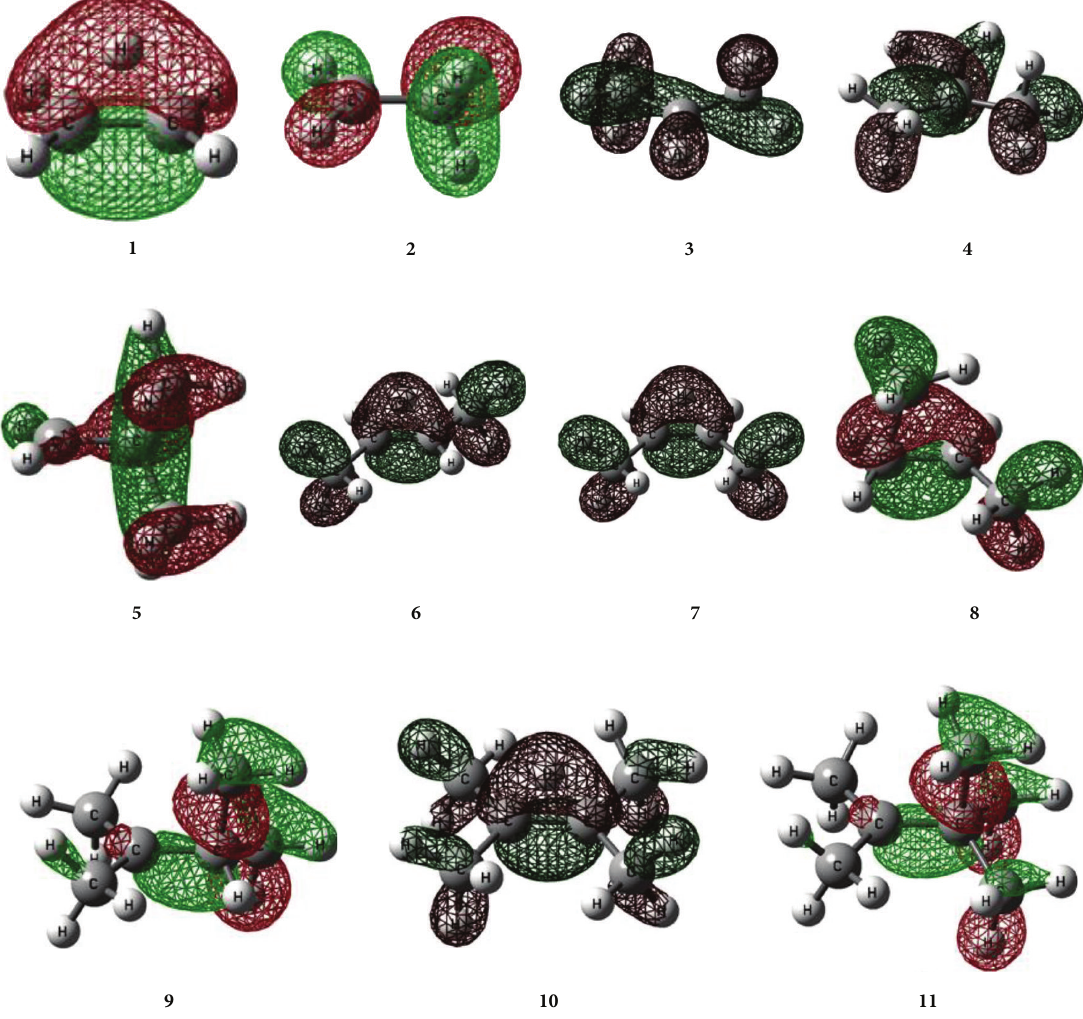
Figure 2: HOMO orbitals of ethyl cations 1 – 11